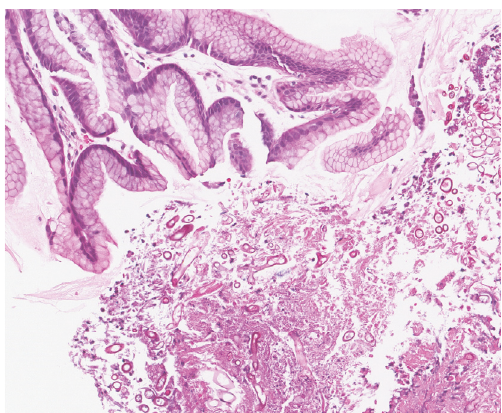
Figure 3: Fungal elements in a background of necrotic and acute inflammatory exudate and unremarkable gastric foveolar epithelia. No evidence of malignancy (x2000).